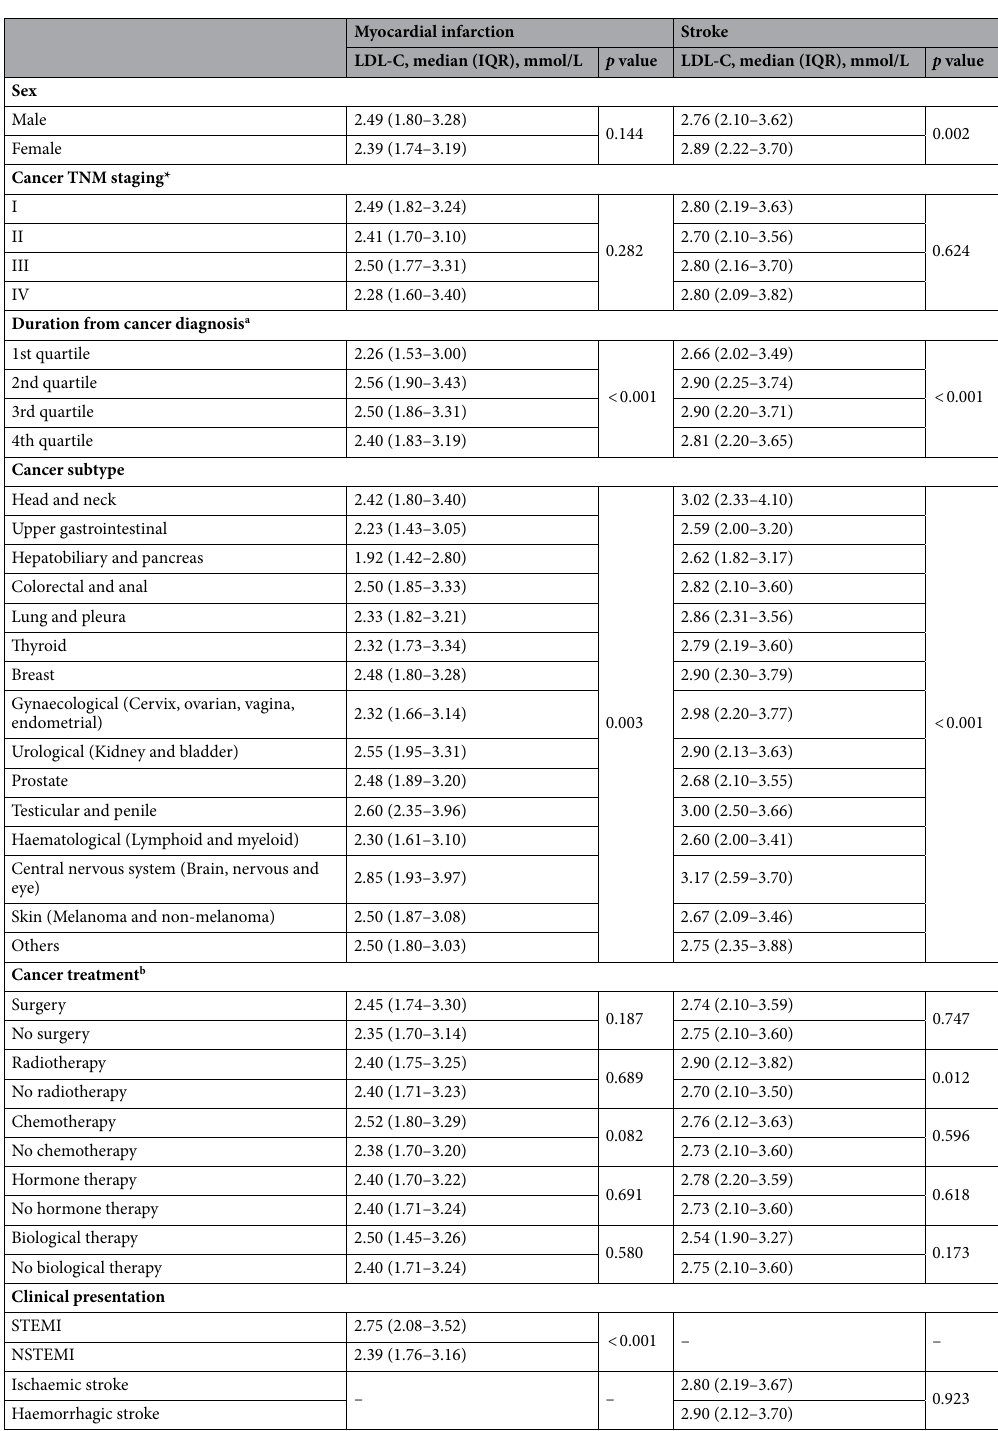
Table 3. LDL-C at incident myocardial infarction or stroke in patients with prior cancer by clinical characteristics. IQR interquartile range, LDL-C low density lipoprotein cholesterol, NSTEMI non ST-segment elevation myocardial infarction, STEMI ST-segment elevation myocardial infarction, TNM tumour node metastasis. *Details on cancer staging are only available for cancer cases diagnosed from 2003 onwards. a Quartile range differs between myocardial infarction and stroke cohorts. Myocardial infarction